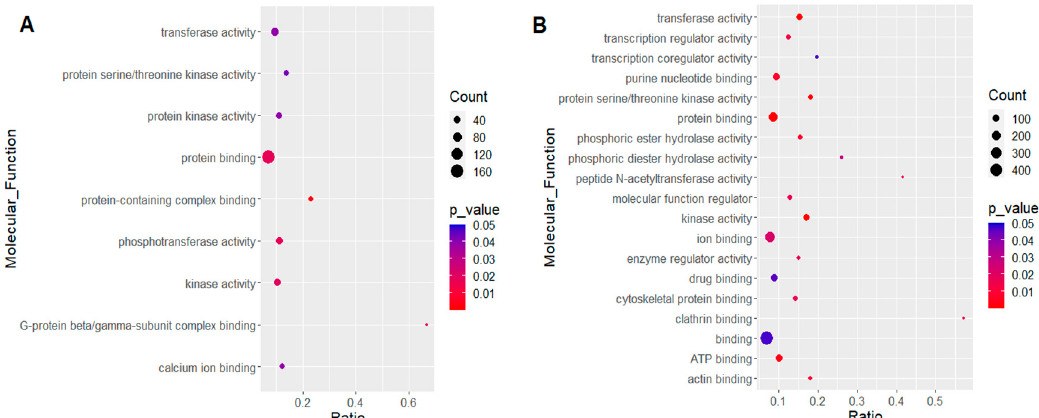
Figure 1. Gene Set Enrichment Analysis (GSEA) of molecular functions for differentially expressed transcripts after feeding with normal plasma (NB) and compared to those fed with heat-inactivated plasma (IB). ( A ) Upregulated transcripts. ( B ) Downregulated transcripts.